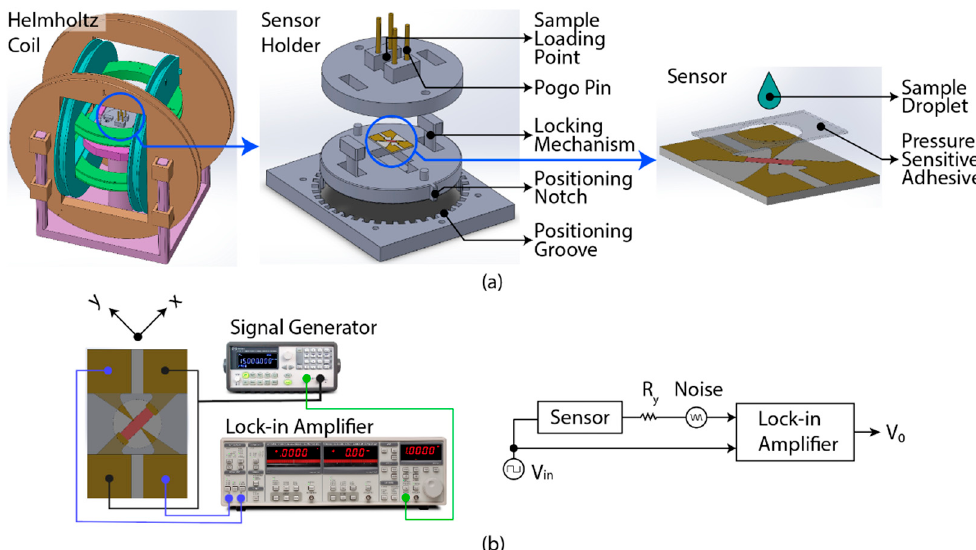
Figure 2. Experimental setup: ( a ) EPHE sensor mounting mechanism to the 3-axis Helmholtz coil with the sensor holder. The Helmholtz coil allows the magnetic excitation, and the sensor holder allows manual rotation of the sensor at different magnetization angles. ( b ) Sensor’s measurement setup and simplified diagram. The signal generator excites the sensor with a constant AC, and the lock-in amplifier measures the hall voltage.